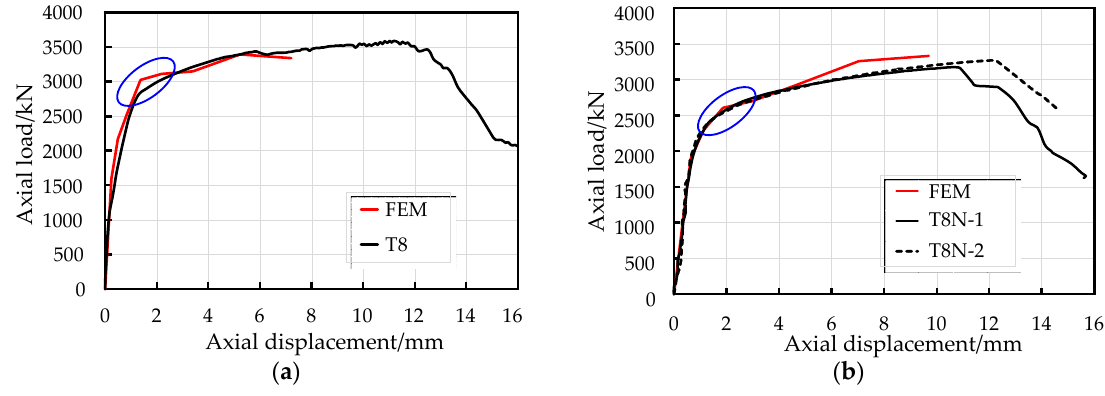
( b ) Figure 12. Comparisons of load–strain curves: ( a ) specimen T8N-1 and ( b ) specimen T8N-2. 5.2.2. Comparison of Load-Displacement Behavior The predicted yield load (N y ) and ultimate axial compressive load (N u ) were computed by the model proposed above. The load-displacement curves of EFCCC columns obtained from the FE analysis have good agreement with that obtained from experiments and is shown in Figure 13. However, the model did not accurately predict the ultimate displacement (e u ) values of specimens T8 and T8N, which the model calculated to be 7.2 mm and 9.7 mm respectively; this inaccurate prediction was caused by the non-convergence of the outside unconfined concrete. The predicted results of the specimens are presented in Table 6. The average overestimation of N y by the proposed